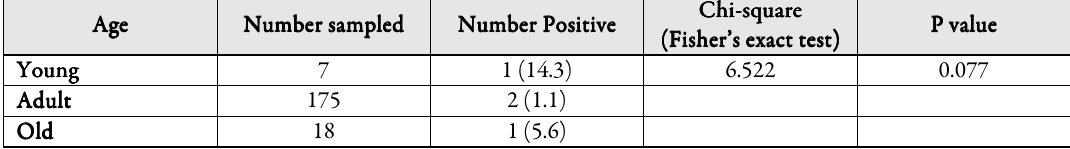
Table 4. Fisher’s exact test-based association analysis of trypanosomosis in trade horses of different ages